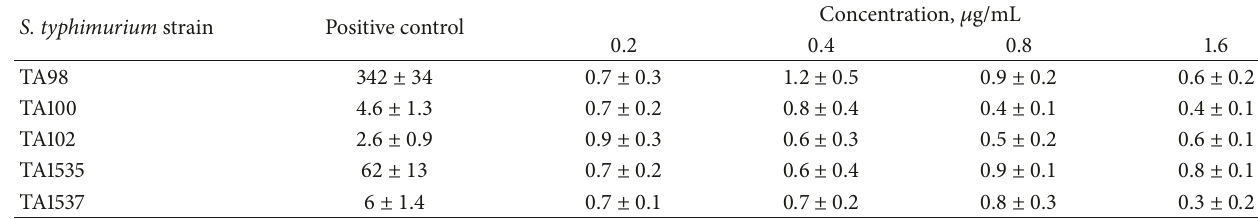
Table 3: Mutagenicity of 4b in the Ames test (ratio, fold increase over the solvent control).